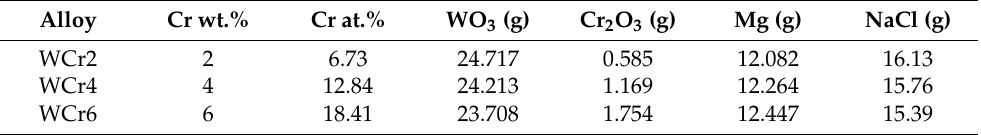
Table 1. Weighing of the reactants for the synthesis of 20 g of the different alloys. WCr2, WCr4 and WCr6 stand for 2, 4 and 6 weight percent chromium in the resulting tungsten alloy. Alloy Cr wt.% Cr at.% WO 3 (g) Cr 2 O 3 (g) Mg (g) WCr2